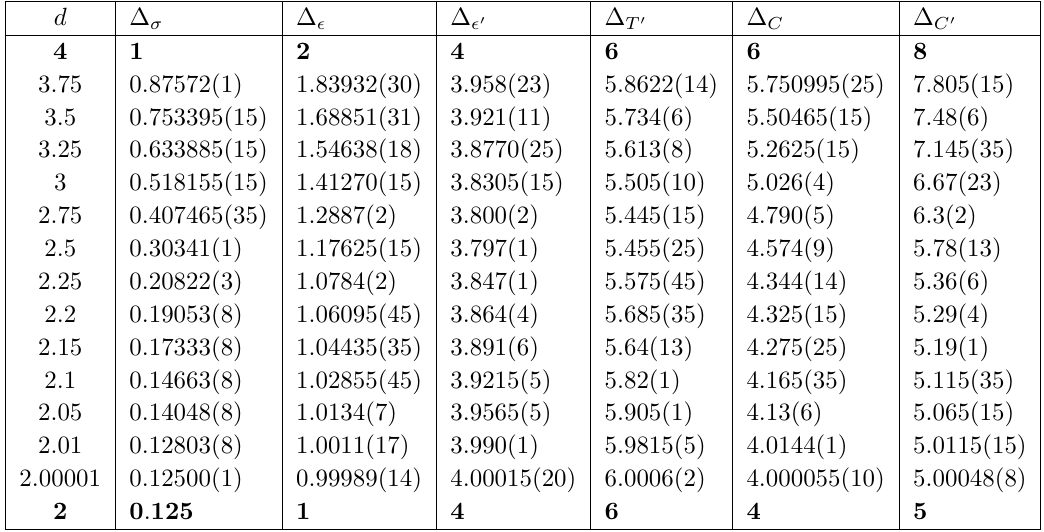
Table 3 . Dimensions of six low-lying states for 4 > d > 2. The exact values for d = 2 ; 4 are given in